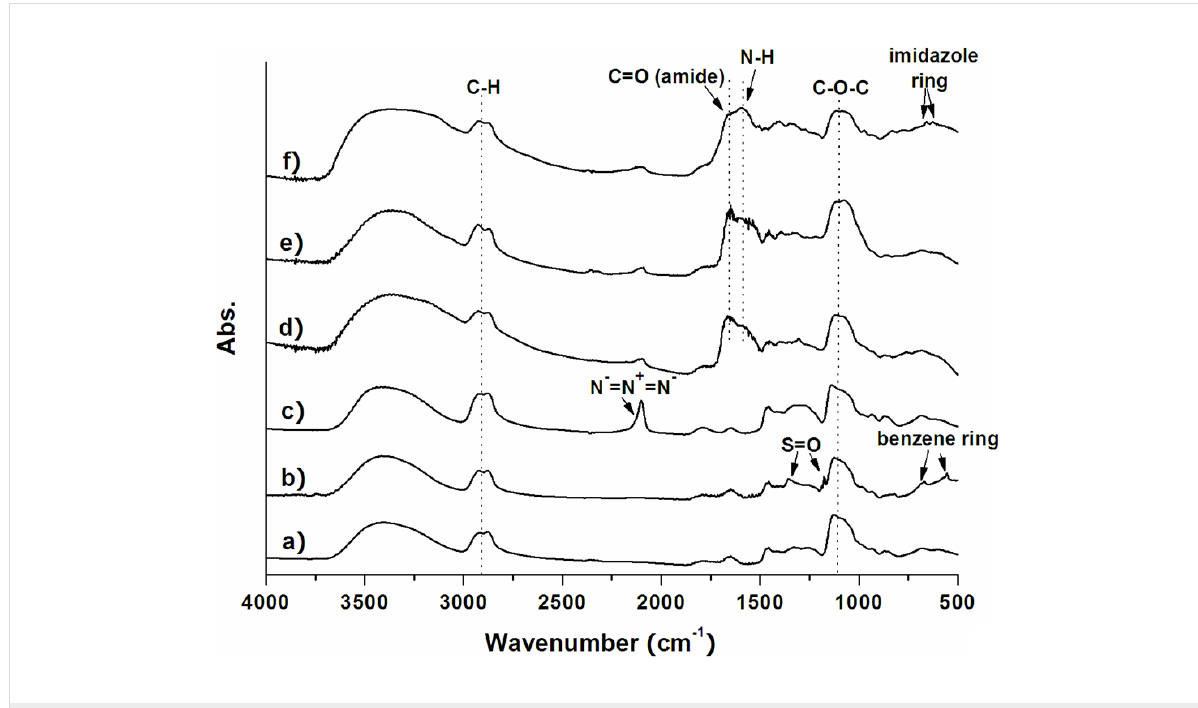
Figure 1: FTIR spectra of a) ND50-PG, b) ND-PG-OTs, c) ND-PG-N 3 , d) ND-PG-Arg 8 , e) ND-PG-Lys 8 , and f) ND-PG-His 8 . Arrows indicate new absorption bands in each